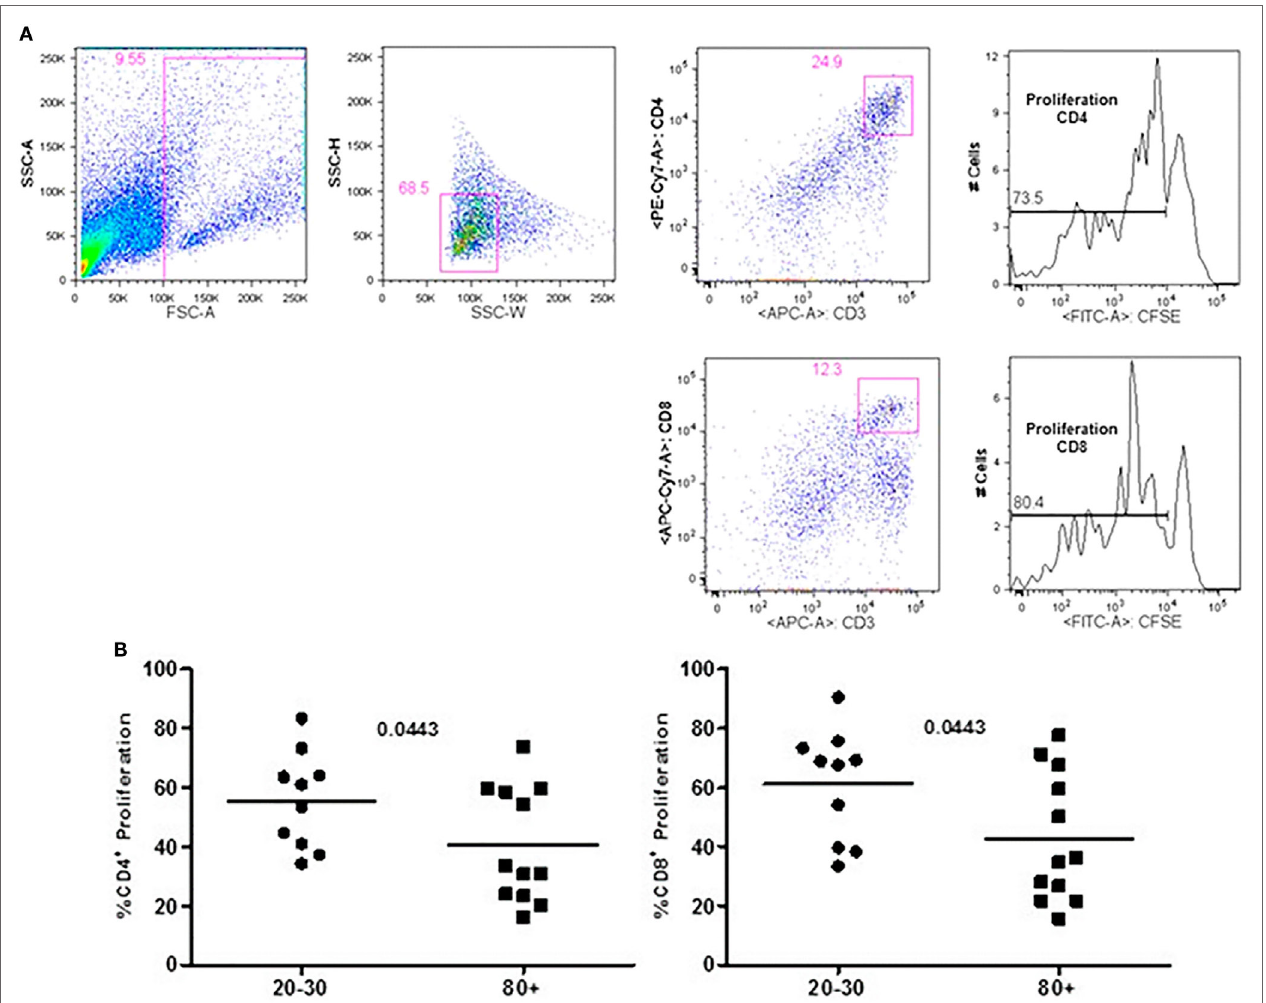
FigUre 5 | Representative flow cytometry plots showing gate strategy for the frequency of proliferation in CD4 + and CD8 + T cells after stimulus with phytohemagglutinin (PHA) in culture. Gate in live cells (FSC-A × SSC-A), doublets exclusion (SSC-H × SSC-W), gate in CD3 + CD4 + T cells, gate in the decrease of CFSE, gate in CD3 + CD8 + T cells, gate in the decrease of CFSE (a) . Percentage of CD3 + CD4 + and CD3 + CD8 + T cells proliferation after stimulus with PHA according to age: 20–30 and 80 + years old (b)